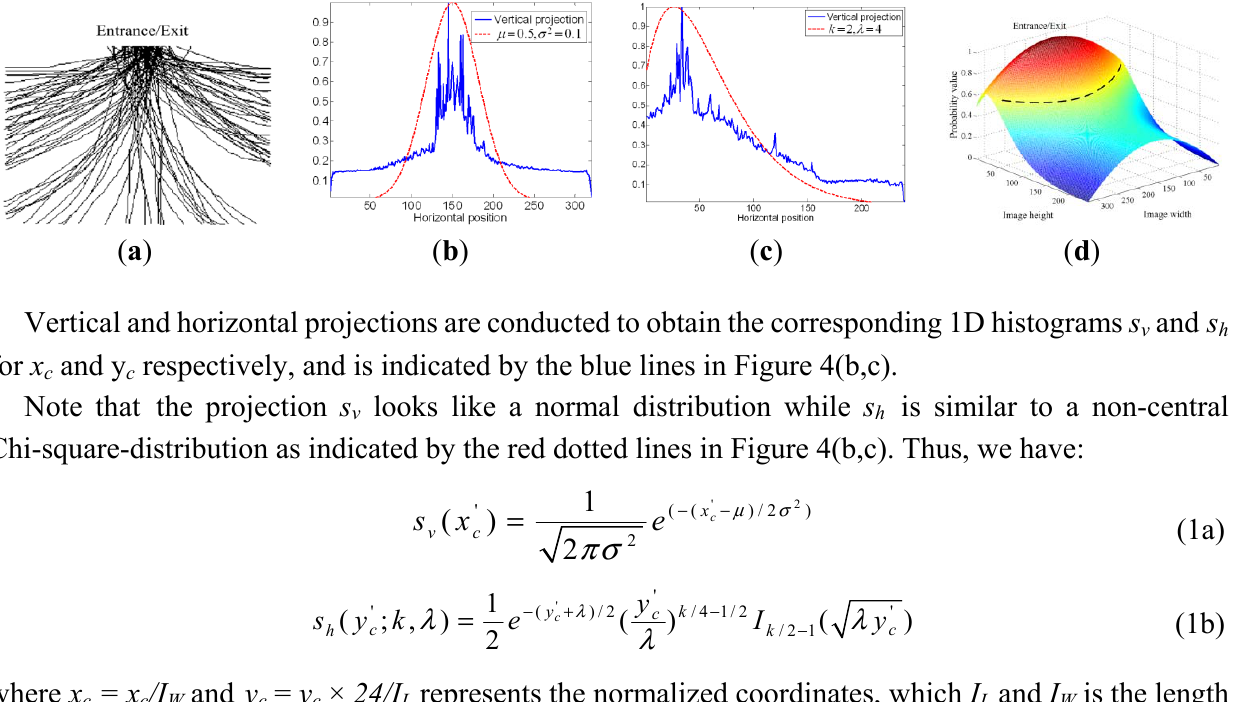
Figure 4. The trajectories and the pdfs ( a ) Trajectories approaching the door ( b ) Vertical projection of the trajectories (blue) and the corresponding pdf (red) ( c ) Horizontal projection of the trajectories (blue) and the corresponding pdf (red) ( d ) Probability table for the joint pdf.